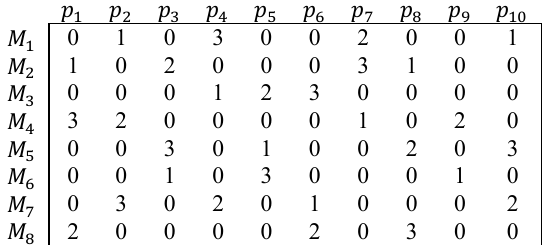
Displacement of machines